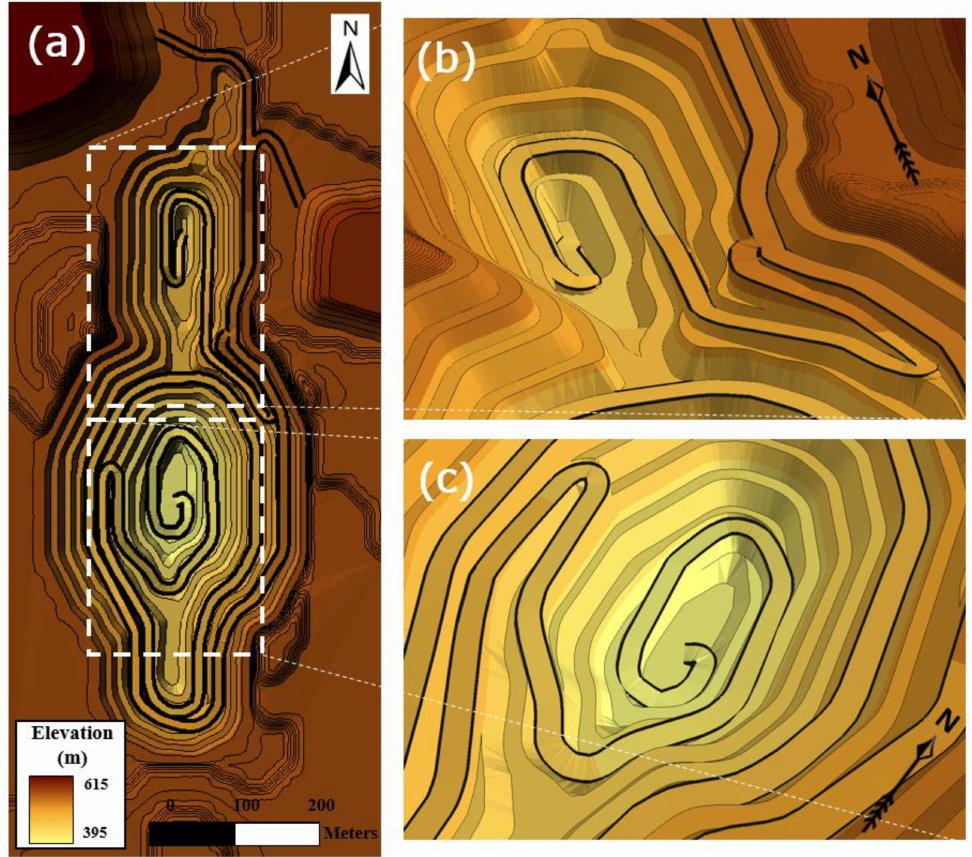
Figure 10. Result of the haul road design. ( a ) Open-pit mine with bench and haul road. 3D views: ( b ) pit 2 area and ( c ) pit 1 area